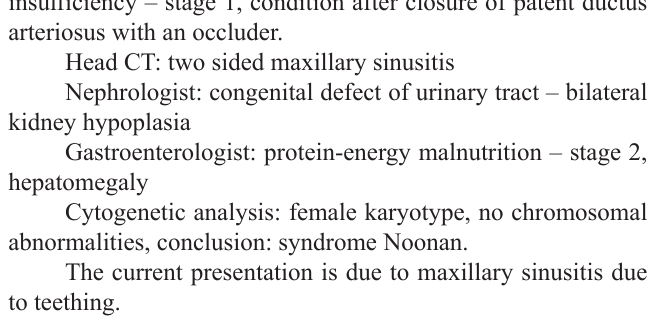
Fig 2: Talipesequinovarus,